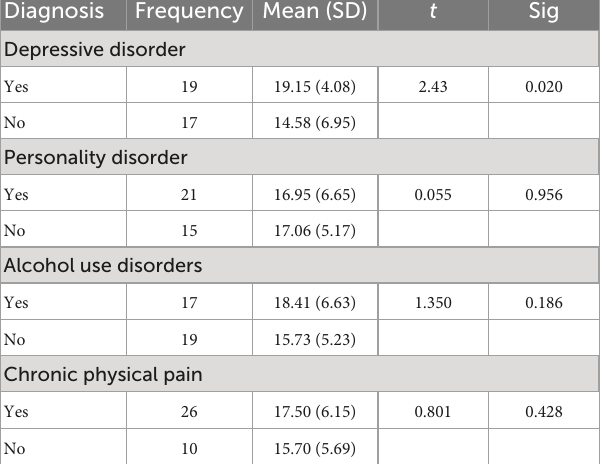
TABLE 5 Association of physical and mental illness comorbidity and suicide intent among individuals with frequent self-harm episodes participated in the interview study ( n =